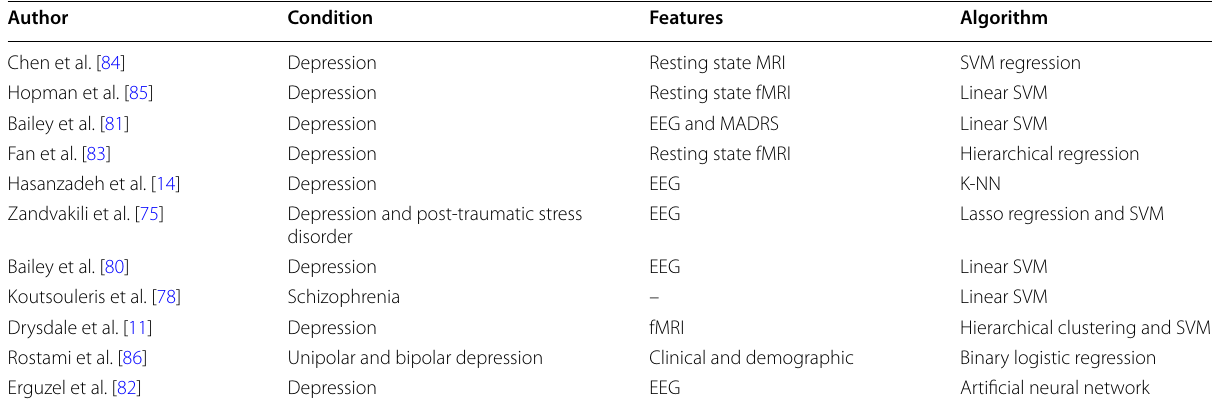
Table 3 rTMS treatment response prediction